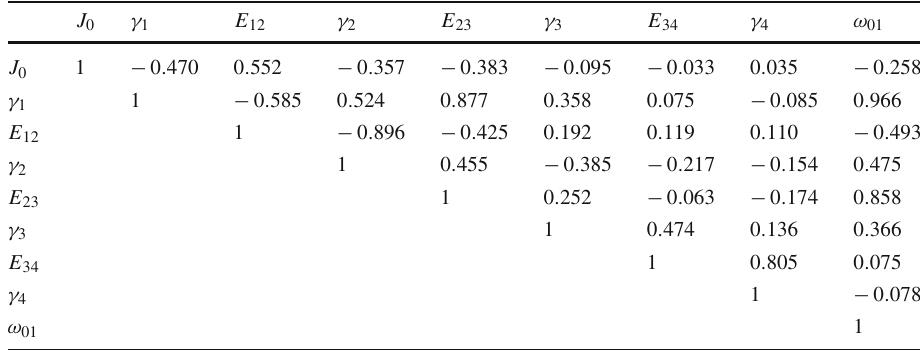
correlation matrix (statistical uncertainties) of the spectral parameters describing the combined SD energy